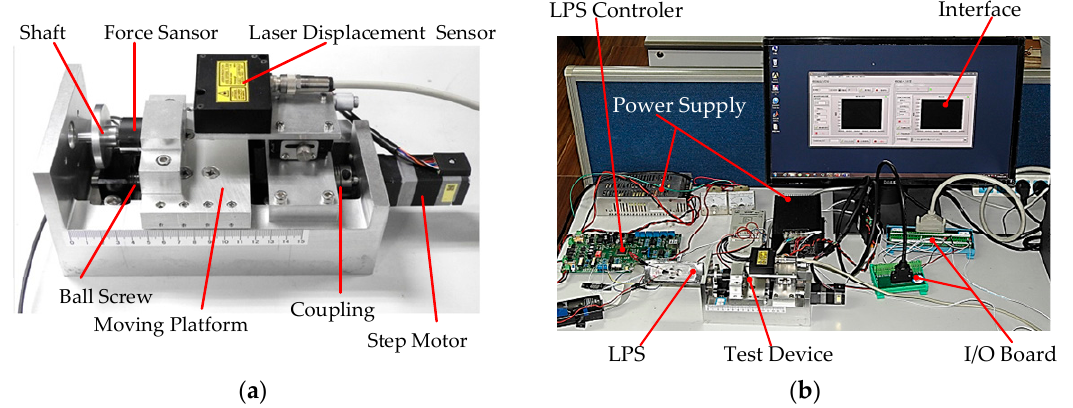
Figure 8. Schematic of performance test: ( a ) test device; ( b ) test and acquisition system.